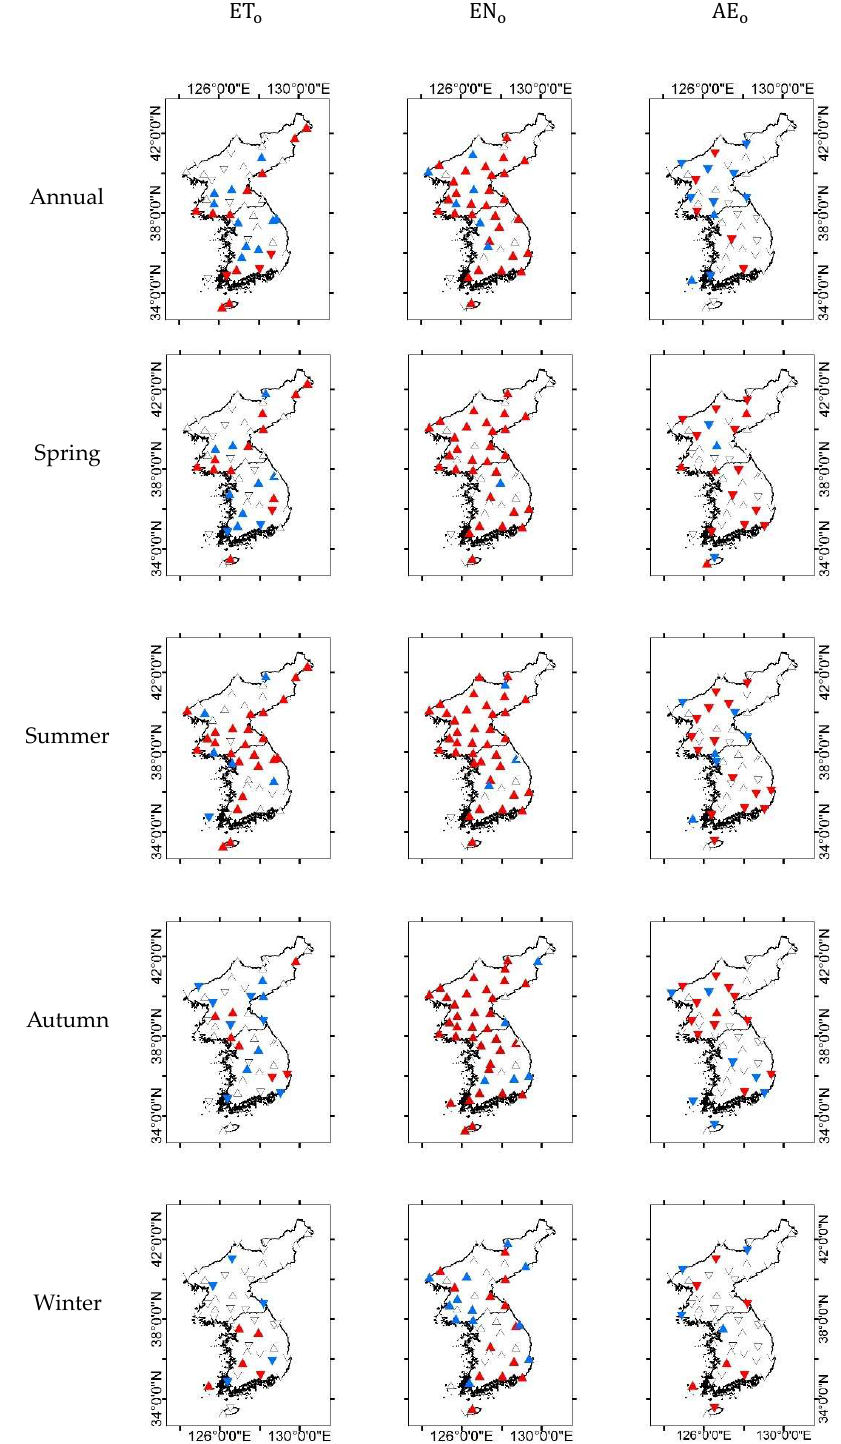
Figure 8. Spatial distribution of stations with increasing and decreasing trends according to the T-test on annual and seasonal ET o , EN o , and AE o during the period 1980 to 2017. Upward- and downward-pointing triangles indicate increasing and decreasing trends, respectively. Blue and red colors shows the 90% and 95% confidence levels, respectively. The white color shows no significant trends.